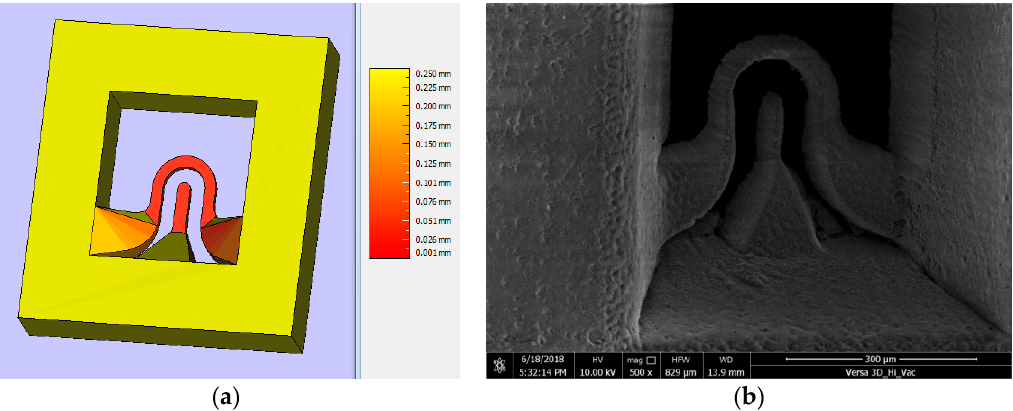
Figure 4. ( a ) 3D model of MEMS microhotplate in *.stl format (Print Screen in Autodesk Inventor CAD program); ( b ) SEM photo MEMS microhotplate immediately after laser micromilling of 250 µm thick Al 2 O 3 substrate using 3D model of MEMS microhotplate in *.stl format as a source